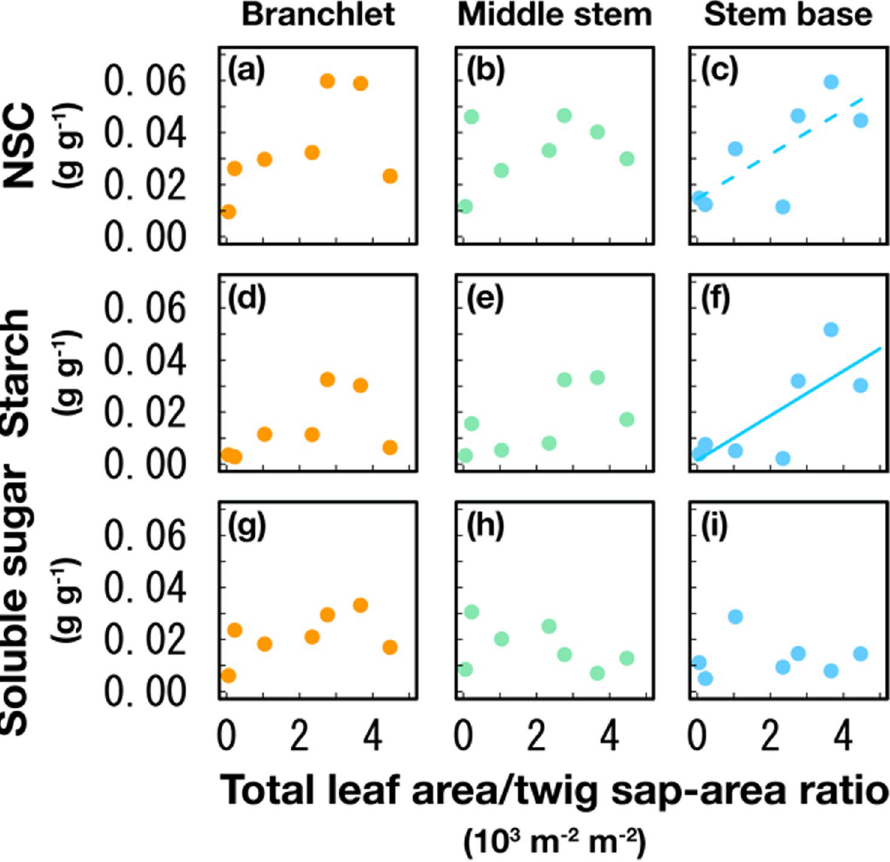
Figure 2. Concentrations of non-structural carbon (NSC), starch and soluble sugar in sapwood. ( a ) NSC in the branchlets (6 mm in diameter). ( b ) NSC in the middle stem (20 mm in diameter). ( c ) NSC in the stem base. ( d ) Starch in the branchlets. ( e ) Starch in the middle stem. ( f ) Starch in the stem base. ( g ) Soluble sugar in the branchlets. ( h ) Soluble sugar in the middle stem. ( i ) Soluble sugar in the stem base. The symbols indicate the branchlets (orange color), middle stem (green color) and stem base (blue color). Ordinary least-squares linear regression lines were drawn for statistically significant results ( α = 0.05), and the dotted line indicates the decreasing trend of NSC in the stem base with declining tree health ( R 2 = 0.56, p = 0.052). The measurements were conduced in 7 trees, including the dead